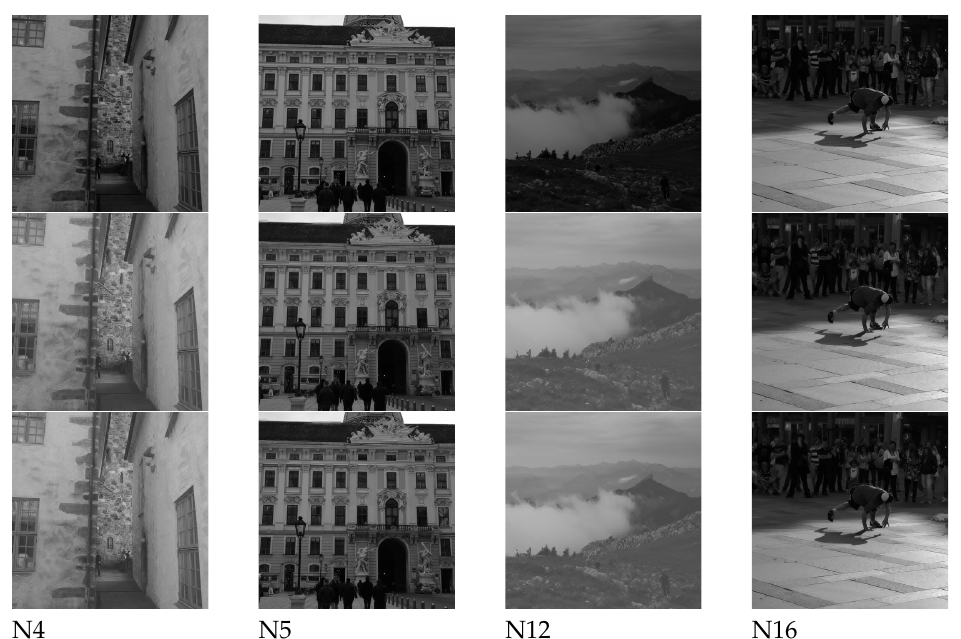
Figure 4. Original images ( first row ), recovered images produced by using Ong et al.’s method [7] ( second row ) and the proposed method ( third row ).